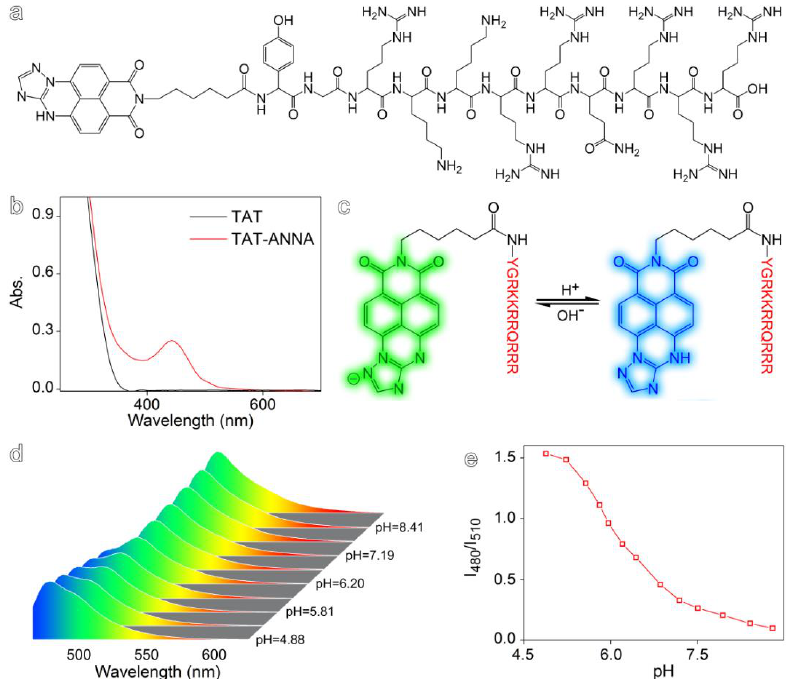
Figure 1. ( a ) Illustration of the TAT-ANNA probe. ( b ) Ultraviolet−visible absorption spectrum of the TAT peptide and the TAT-ANNA probe. ( c ) Protonation/deprotonation-induced structural transformation of the TAT-ANNA probe. ( d ) Fluorescence spectra of TAT-ANNA recorded at different pH values excited at 455 nm.